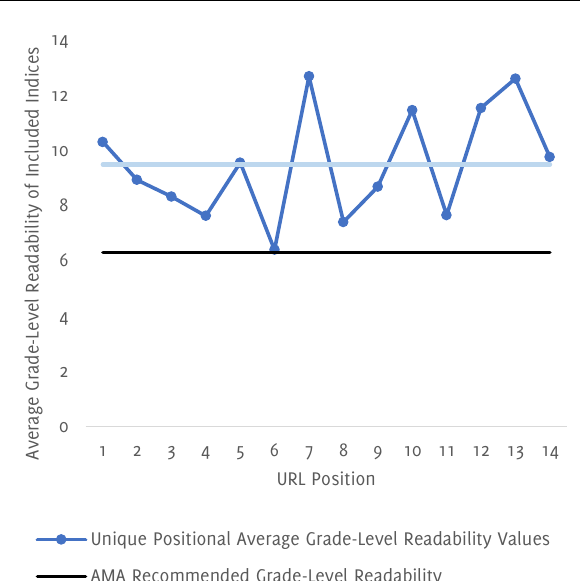
Figure 2 . Grade-Level Readability Values for First 14 URLs in a Google Search for “pap smear” Compared to Superimposed Static Lines Representing